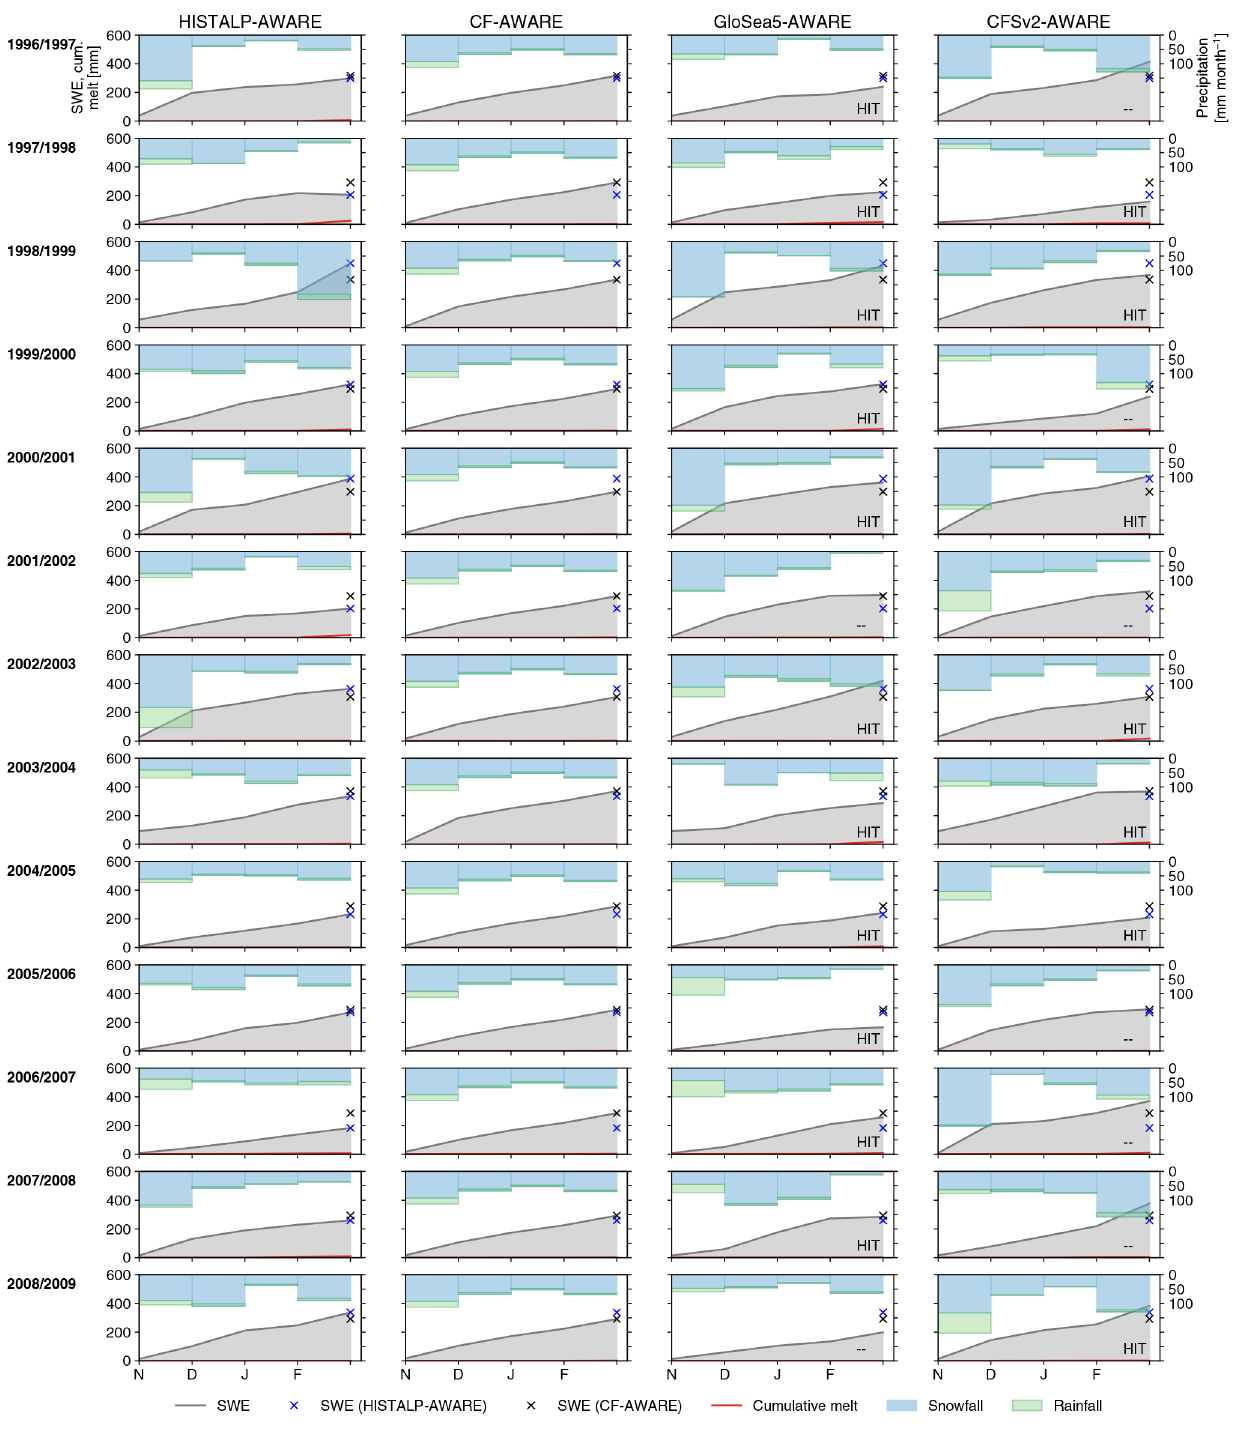
Figure 5. Water balance of the basin-scale snow storage for each year and each forcing data set used for AWARE simulations. CF is the climatological forecast (long-term averages of HISTALP) which can be viewed as forecast yielding average conditions. The evolution of snow accumulation is categorized either “HIT” or “–” if the sign of anomalies obtained from HISTALP-AWARE and CM-based AWARE runs matches or mismatches